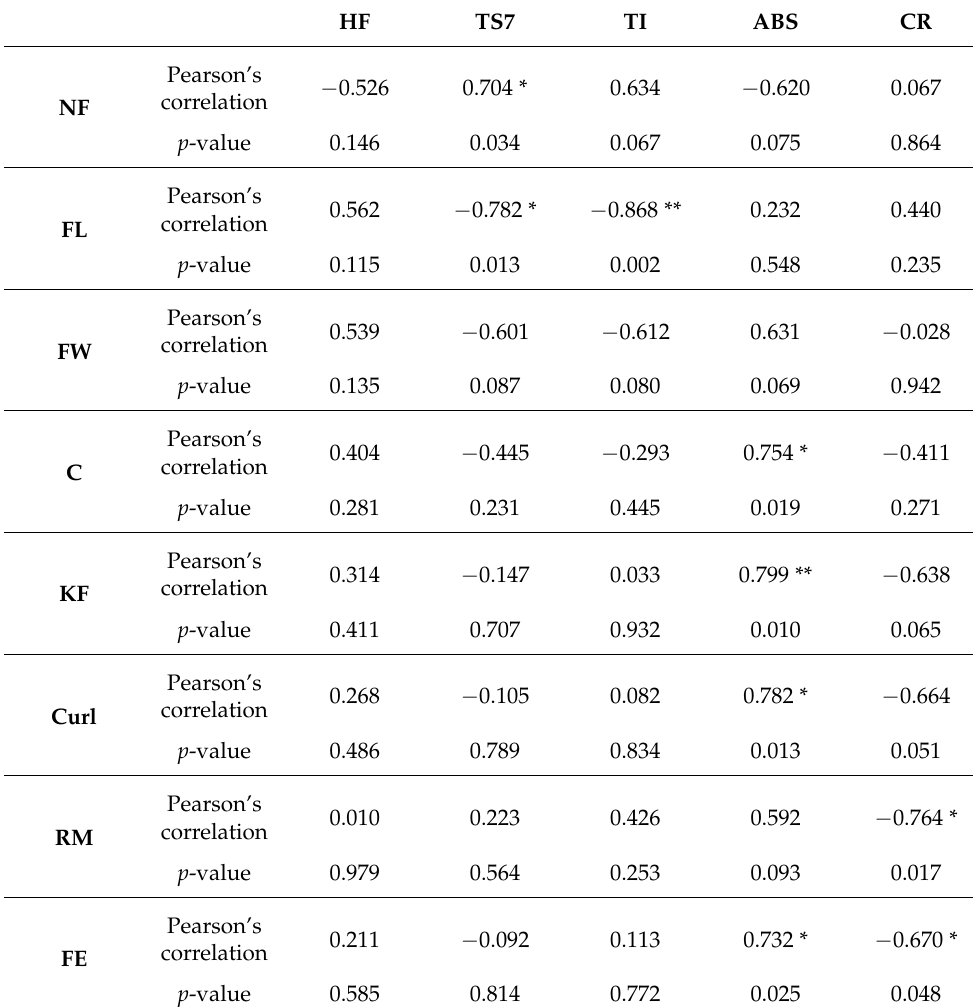
Table 6. Pearson’s correlation values for fiber morphology and functional properties.